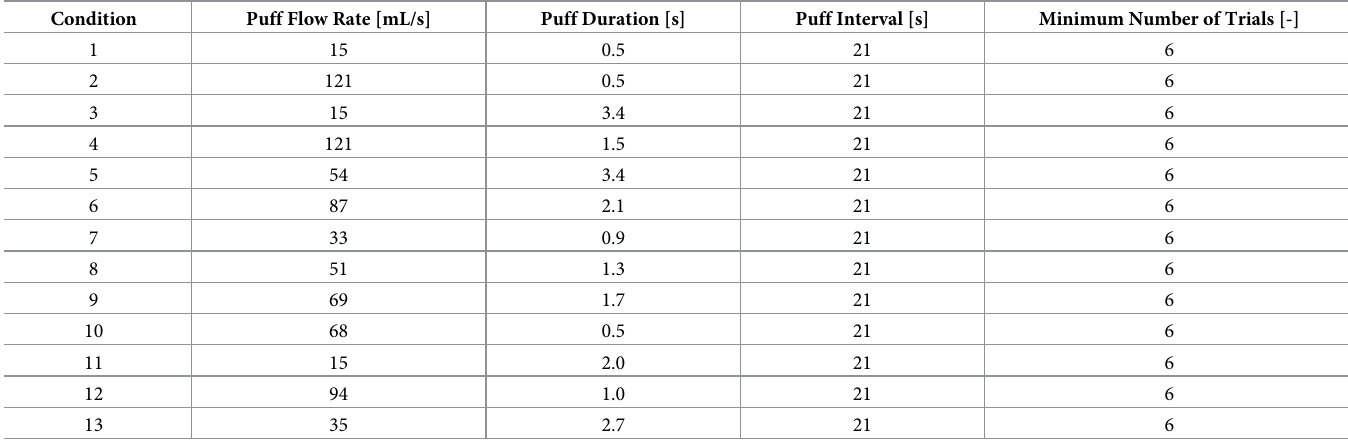
Table 1. Proposed emissions topography protocol reflecting smoker’s use behavior in their natural environment for cigarette emissions characterization